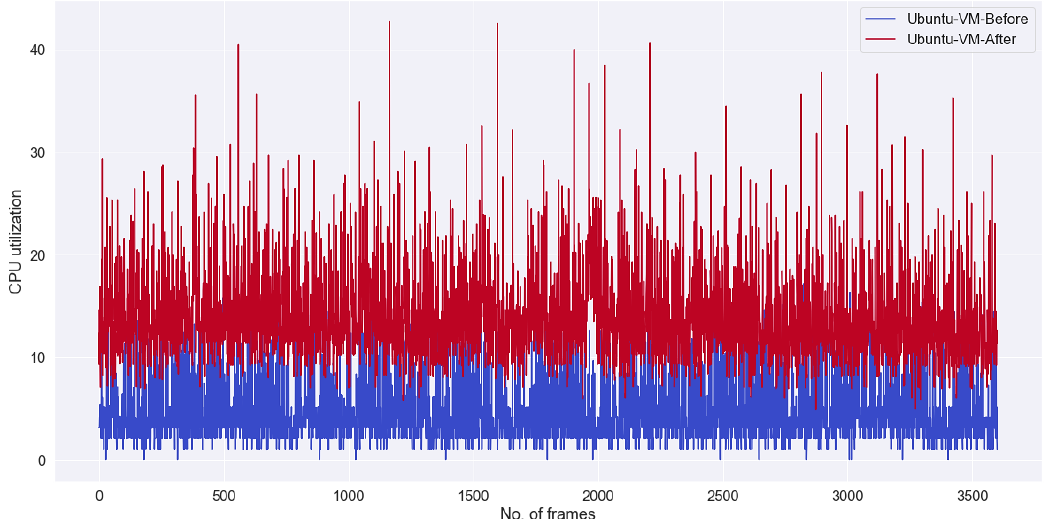
Figure 39. Ubuntu VM CPU utilization before and after installing